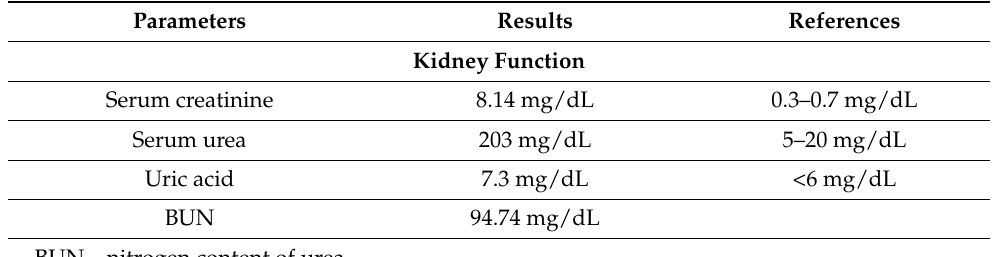
Table 1. Kidney laboratory parameters on